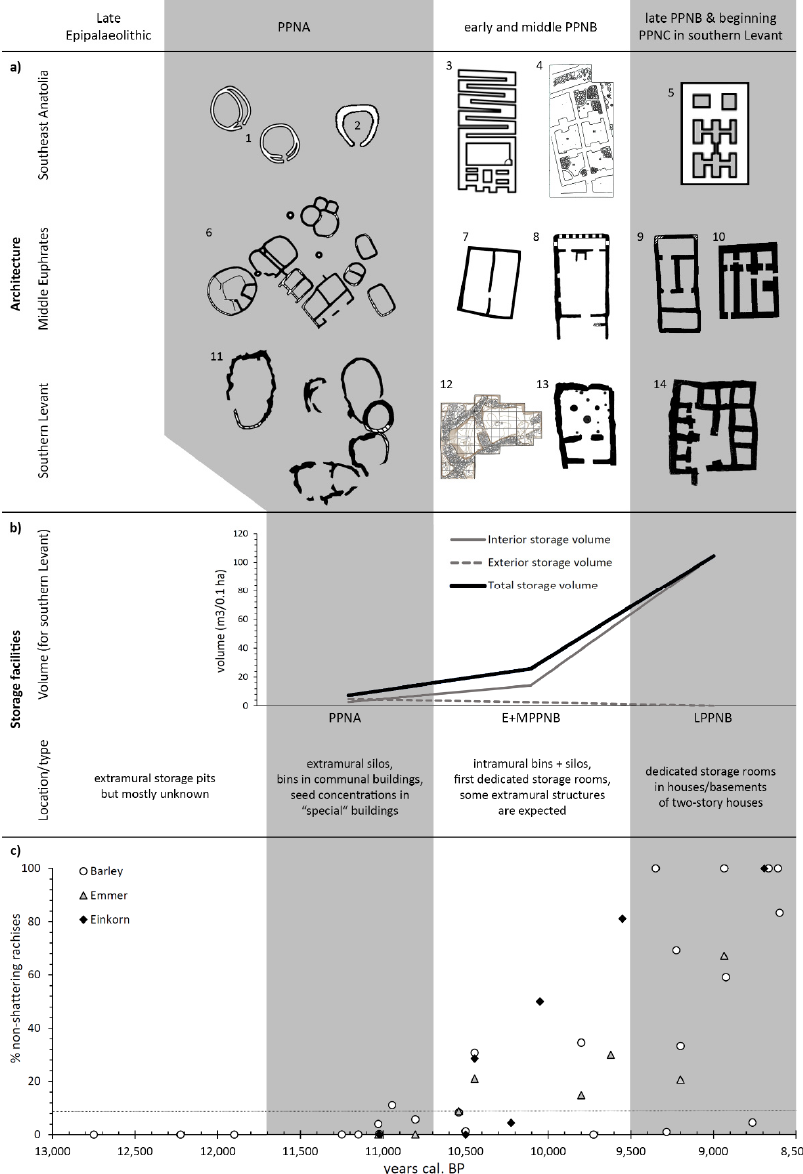
Figure 2. Correlation of architectural developments, storage systems, and proportions of non- shattering spikelets throughout the PPN. ( a ) examples for architectural developments (not to scale); ( b ) storage capacities and modes based on [33,55]; ( c ) proportions of non-shattering spikelets in charred cereal chaff assemblages, data based on [24] and modified (see Table S1 and Appendix A). Architectural plans redrawn from [32,36,68–70]: (1) Hallan Çemi (level 1), (2) Çayönü (round building subphase), (3) Çayönü (grill plan subphase), (4) Cafer Höyük (Level VIII), (5) Çayönü (cell building subphase), (6) Jerf el Ahmar (I/east), (7) Dja’de (phase 2), (8) Tell Halula, (9) Tell Abu Hureyra (phase 2B), (10) Tell Bouqras (phase III), (11) Netiv Hagdud (“upper area”), (12) Tell Qarassa North